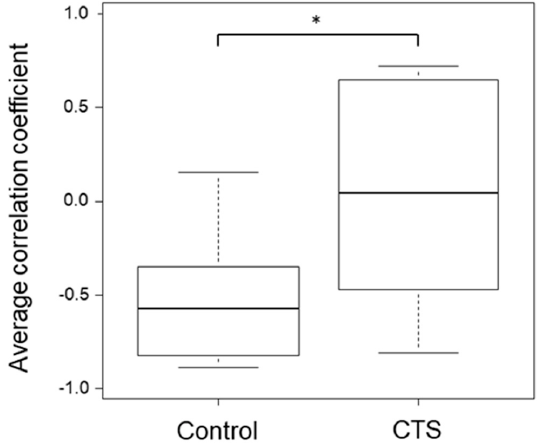
Figure 6. Box plot showing the average correlation coefficient in the control and carpal tunnel syndrome (CTS) group. Upper whisker, 90th percentile; box top, 75th percentile; central line, median; box bottom, 25th percentile; lower whisker, 10th percentile.